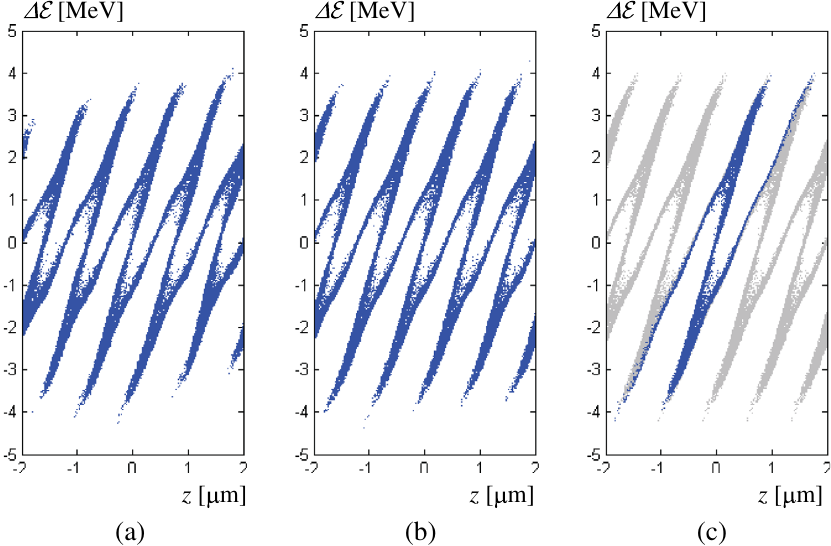
FIG. 11. Application A: longitudinal phase space direct after chicane 3. (a) Calculated with QField-non-periodic, one million macro- particles, 30 fs (FWHM) laser modulation, (b) calculated with QField-non-periodic, 20 million particles, 60 fs (FWHM) laser modulation, (c) calculated with QField-periodic.